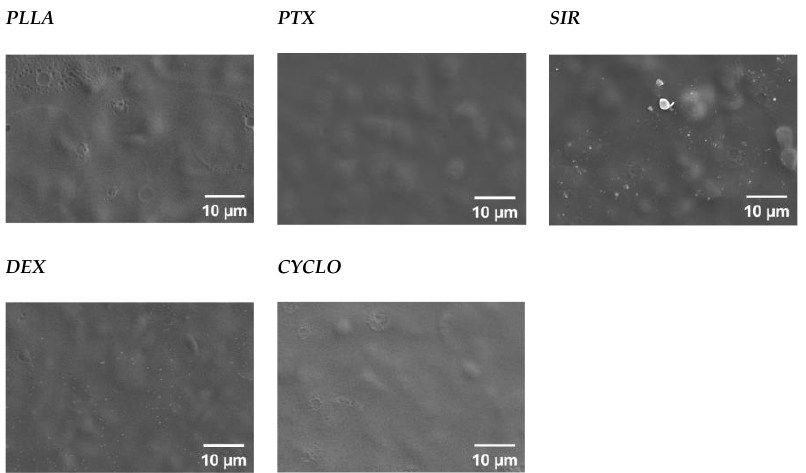
Figure 3. Exemplary SEM images for different drugs incorporated in PLLA samples (PLLA/drug 80/20 w / w %). Drugs used were paclitaxel (PTX), sirolimus (SIR), dexamethasone (DEX) and cis- losporine